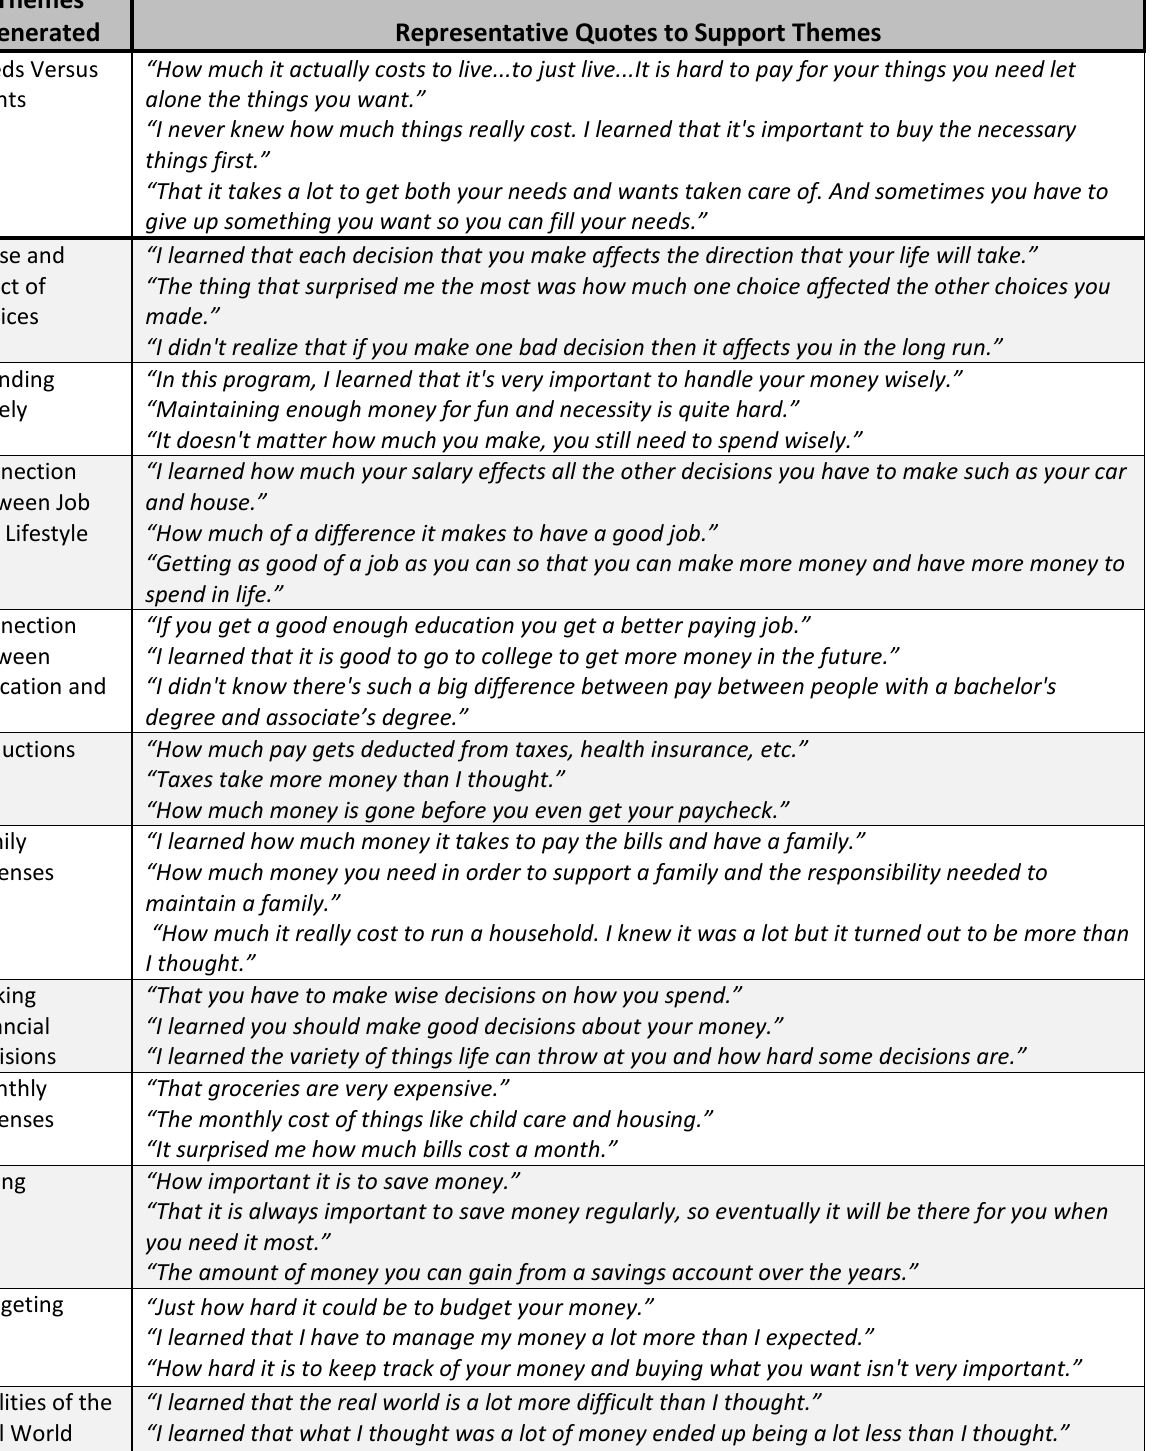
Self-Reported Learning by Real Money. Real World.